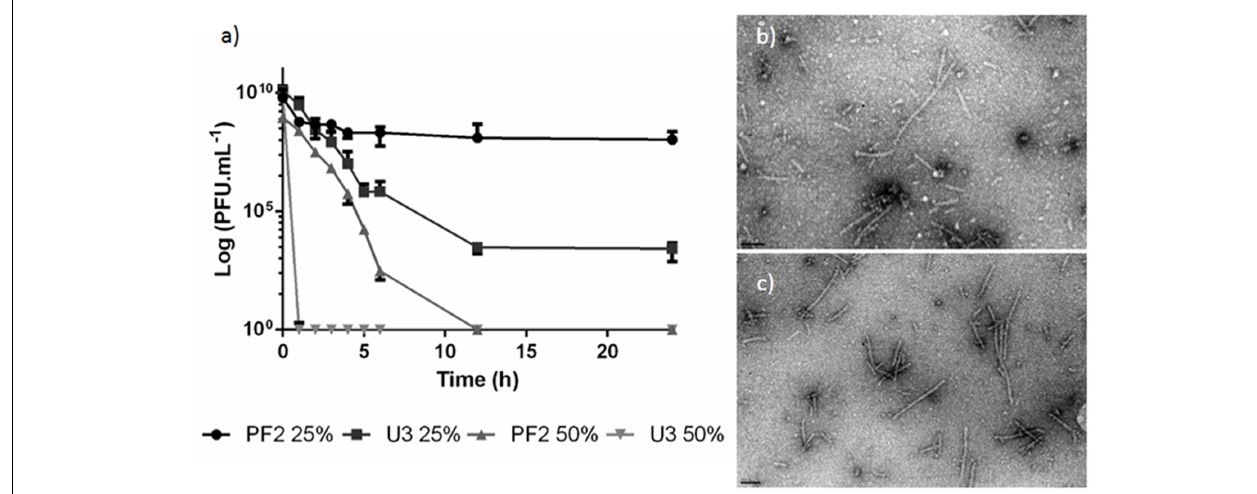
FIGURE 2 | Phage EC3a viability. (a) PFU counts after EC3a exposure to PF2 and U3 honeys at 25% (w/v) and 50% (w/v) concentrations, TEM micrographs of EC3a phage tails after 6 h of contact with honeys with (b) U3 25% and (c) PF2 25% . Scale bar in TEM micrographs is 100 nm.